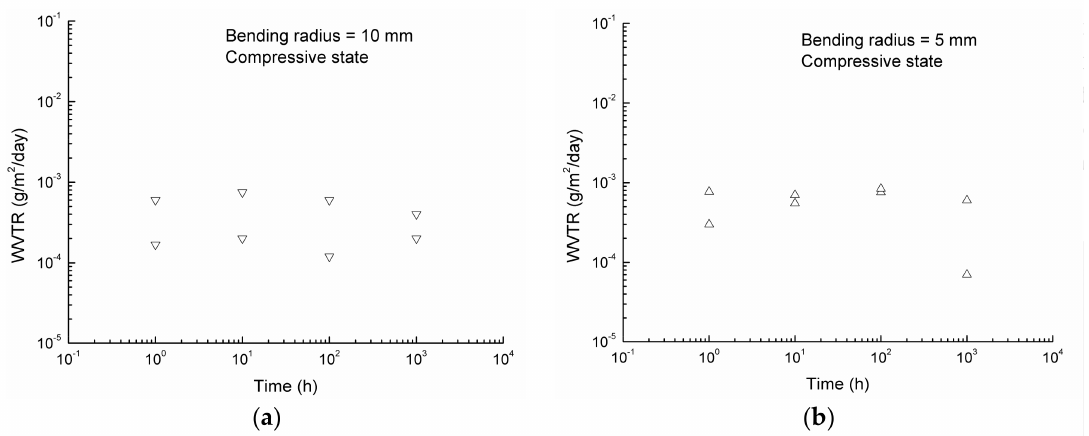
Figure 7. WVTR change of barrier film bent in compressive state: ( a ) bending radius of 10 mm; ( b ) bending radius of 5